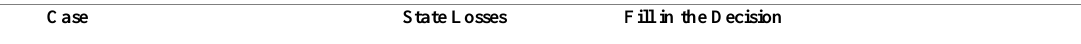
Table 2: Targets for recovery of TP losses. corruption which has a loss value of less than IDR 50,000,000